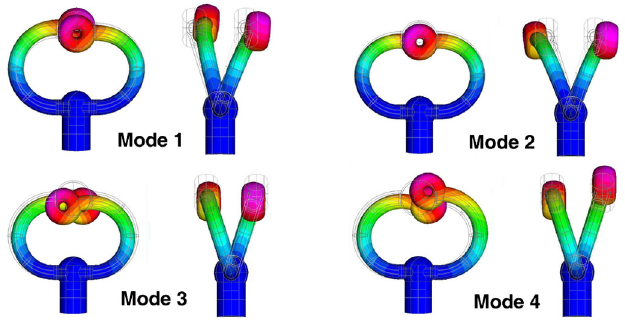
FIG. 4. Experimental setup utilizing a superconducting SLR as a beam phase